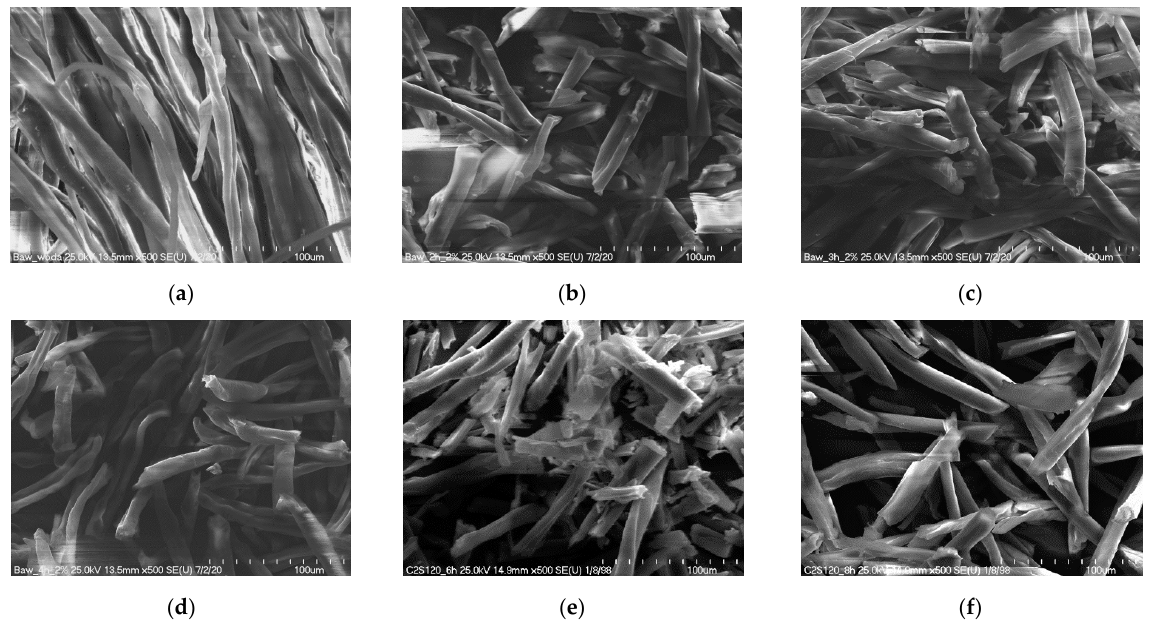
Figure 11. SEM pictures of the solid residue after various hydrolysis times (120 °C, 2% H 2 SO 4 ): cotton treated for ( a ) 1 h, ( b ) 2 h, ( c ) 3 h, ( d ) 4 h, ( e ) 6 h, and ( f ) 8 h.